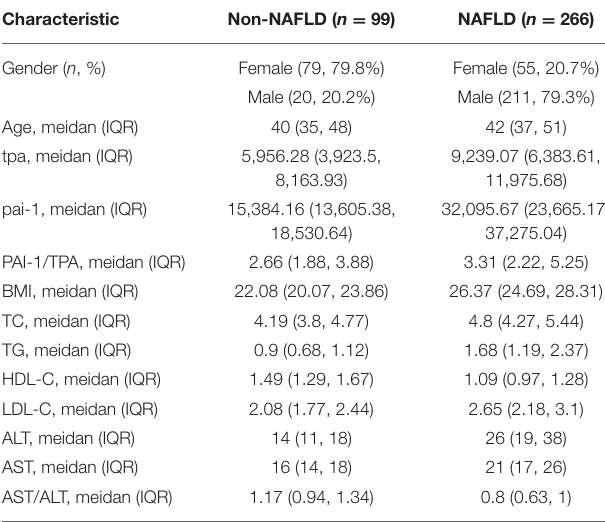
TABLE 1 | The characteristic clinical data between the NAFLD and non-NAFLD patients.